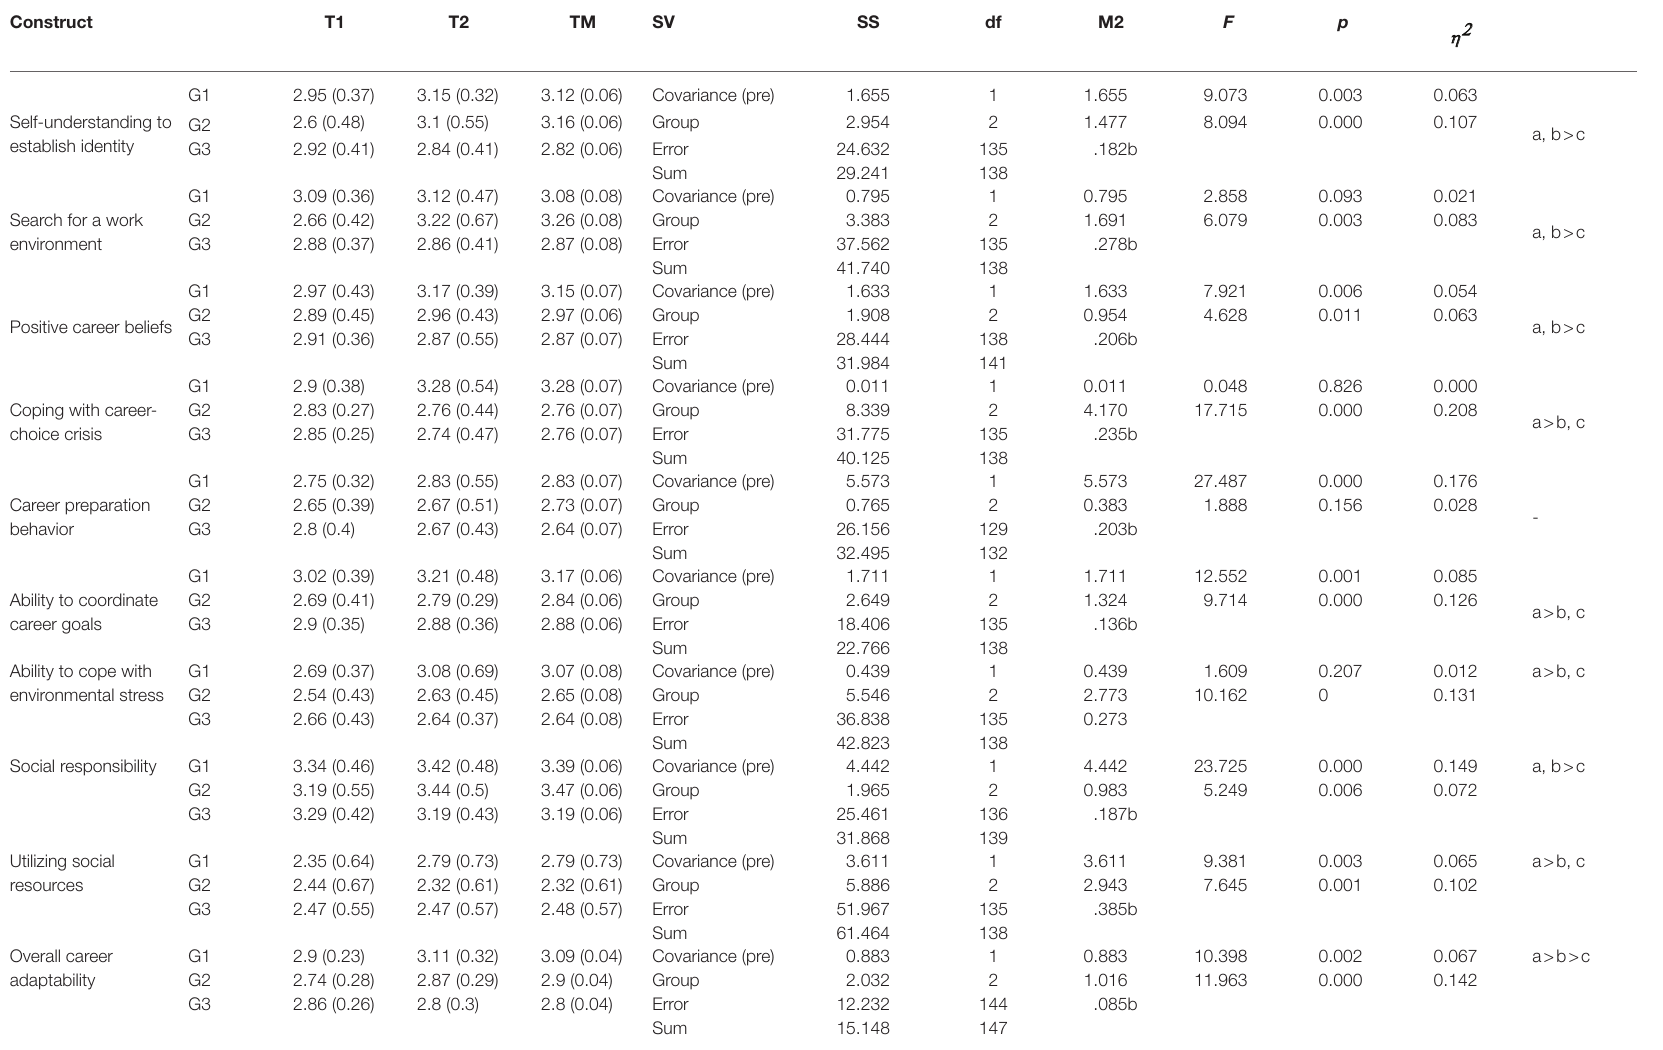
TABLE 6 | Comparison of pre- and post-program scores by group (covariance analysis result).